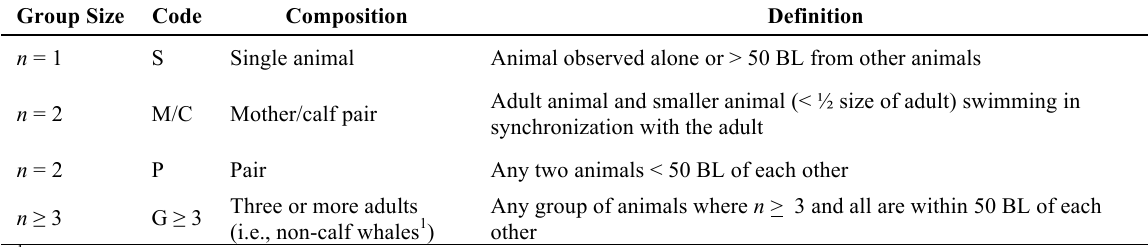
Definition of Group Type (GT) Categories Observed Group Size Code Composition